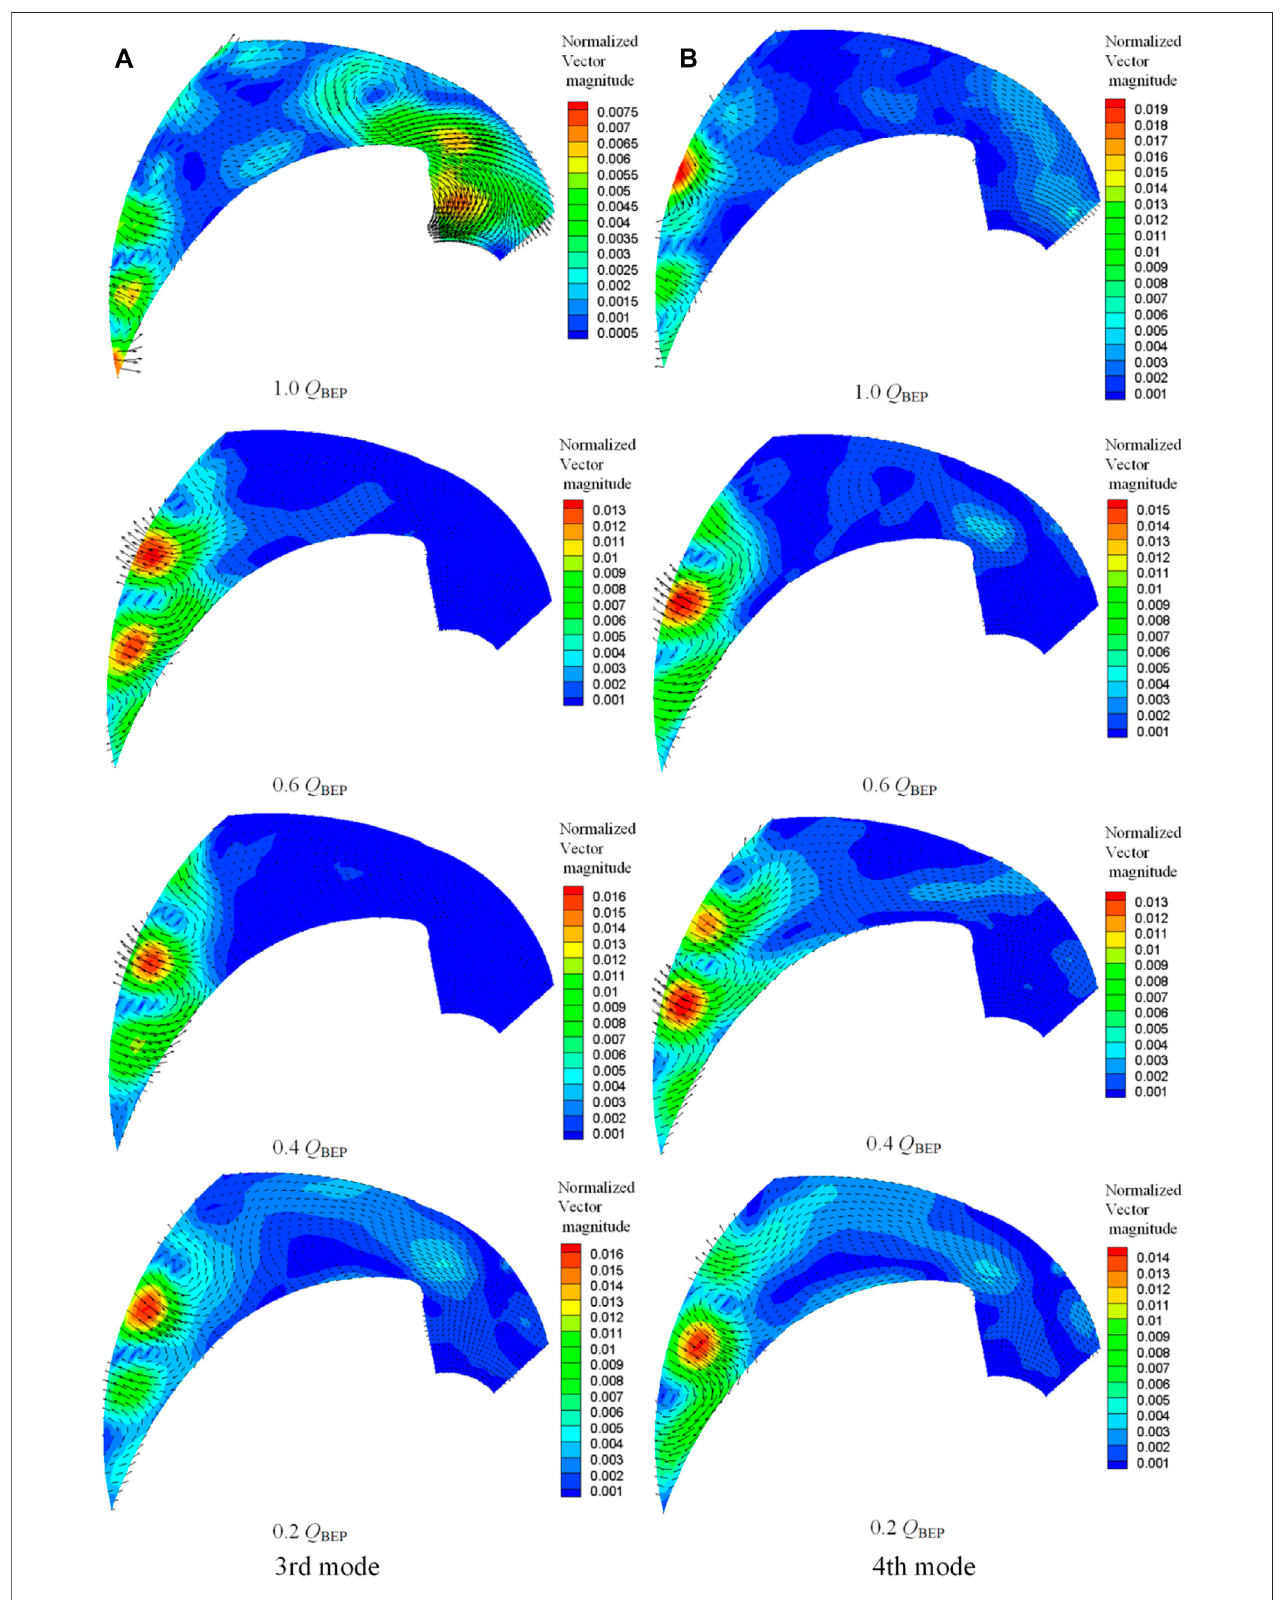
FIGURE 10 | The vector plots of the third and fourth modes for different fl ow rates. (A) Third mode, (B) fourth mode.